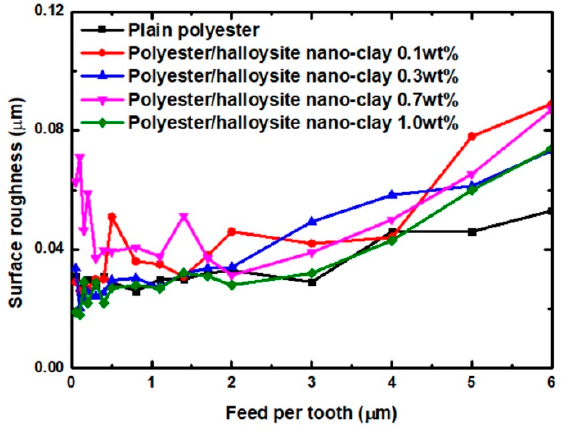
Figure 8. Effect of feed per tooth on the surface roughness. Figure 8. E ff ect of feed per tooth on the surface